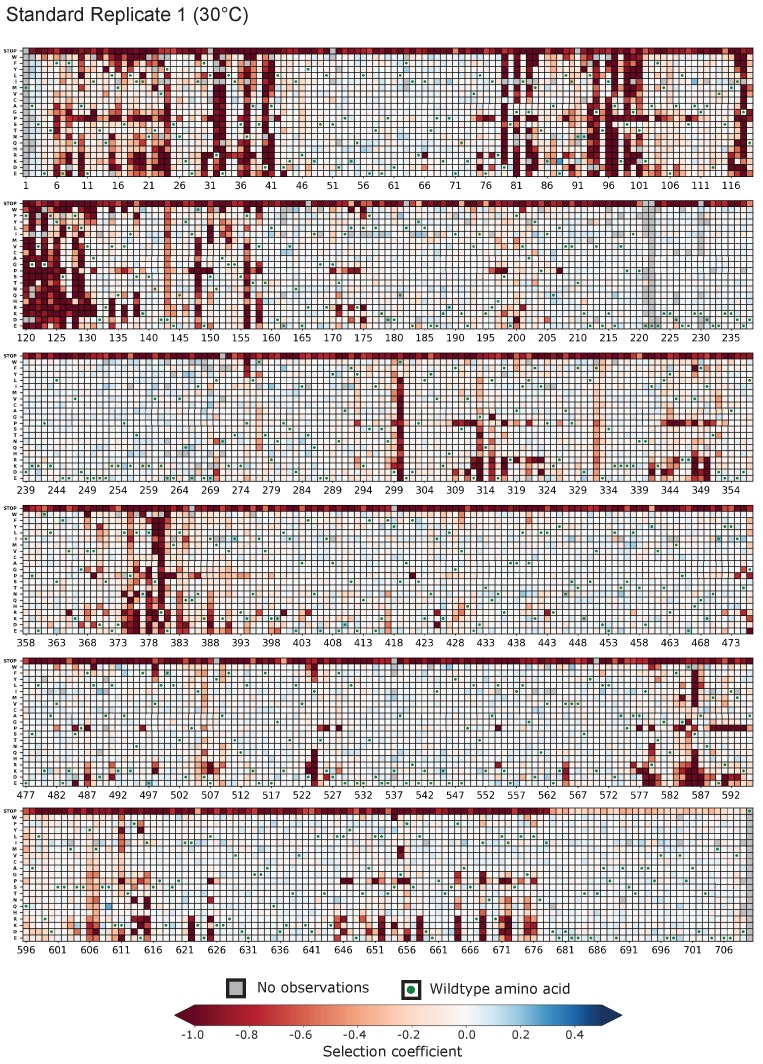
Heatmap representation of the selection coefficients observed for single amino acid changes across amino acids 2–709 of Hsp90 in standard (30°C) conditions in replicate 1.